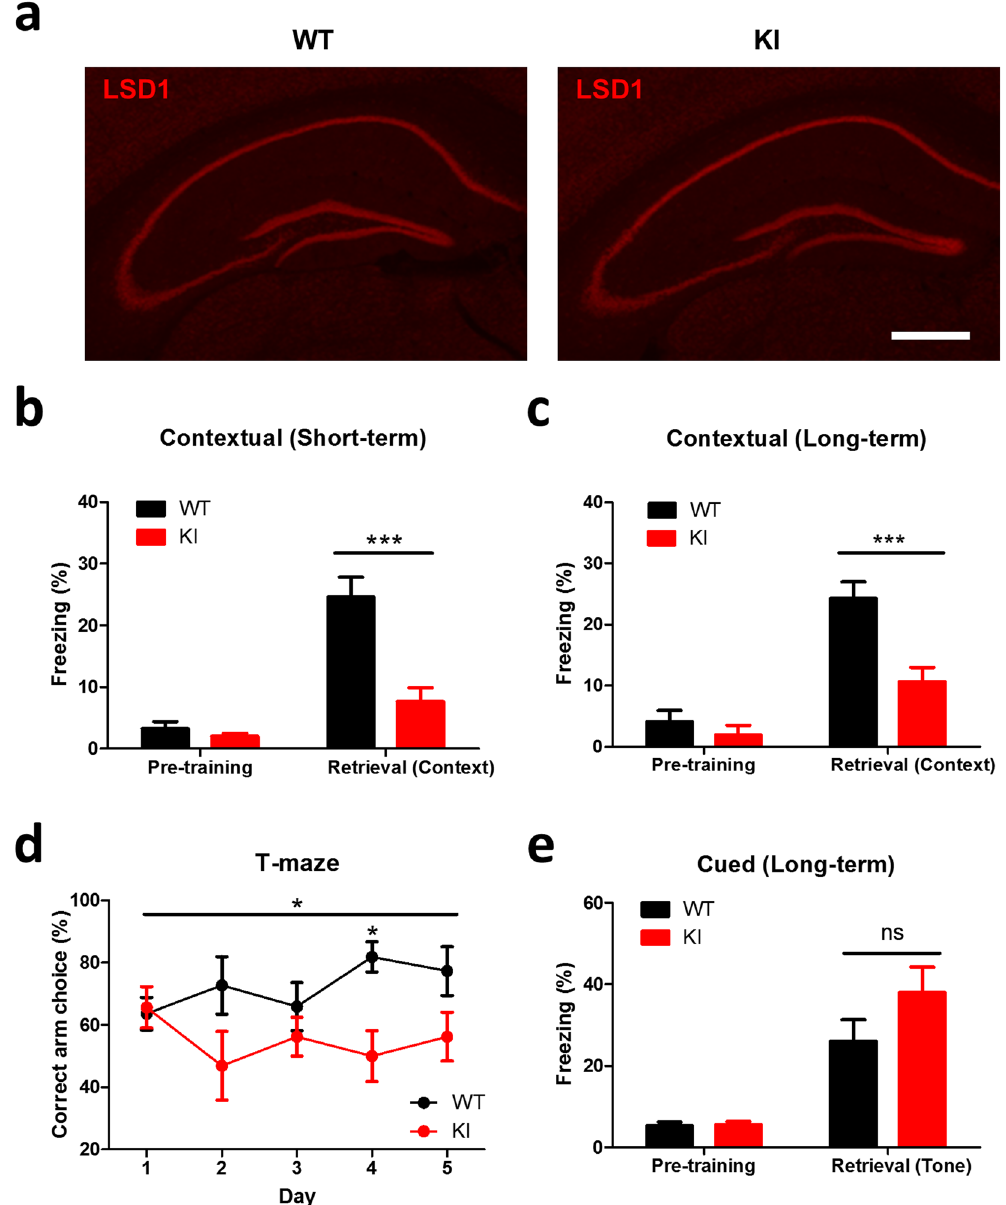
Figure 1. Lsd1 knock-in (KI) mice show impaired hippocampus-dependent fear memory. ( a ) Representative immunohistochemical images (from 5 different animals for each genotype) showed no difference in LSD1 expression pattern in the hippocampus of WT and Lsd1 KI mice. Scale bar: 500 μ m. ( b ) Freezing levels of WT (black) and Lsd1 KI (red) mice before (pretraining) and 1 h after (retrieval) contextual fear conditioning. Lsd1 KI mice showed significantly reduced freezing levels during retrieval test compared to WT (WT: n = 7, KI: n = 6; two-way ANOVA, genotype x condition, F 1,22 = 13.58, p < 0.01; effect of genotype, F 1,22 = 18.21, p < 0.001; effect of condition, F 1,22 = 40.07, p < 0.0001; Bonferroni posttests, *** p < 0.001). ( c ) Freezing levels of WT (black) and Lsd1 KI (red) mice before (pretraining) and 24 h after (retrieval) contextual fear conditioning. Lsd1 KI mice showed significantly reduced freezing levels during retrieval test compared to WT (WT: n = 9, KI: n = 9; two-way ANOVA, genotype x condition, F 1,32 = 7.06, p < 0.05, effect of genotype, F 1,32 = 13.36, p < 0.001, effect of condition, F 1,32 = 44.73, p < 0.0001; Bonferroni posttests *** p < 0.001). ( d ) Correct arm choice rate showed significant impairment in short-term memory in Lsd1 KI mice (WT: n = 11; KI: n = 8; two-way RM ANOVA, genotype x time, F 4,68 = 1.83, p = 0.133, effect of genotype, F 1,68 = 7.53, * p < 0.05, effect of time, F 4,68 = 0.37, p = 0.826; Bonferroni posttests, WT vs KI at day 4, * p < 0.05). ( e ) Freezing levels of WT (black) and Lsd1 KI (red) mice before (pretraining) and 24 h after (retrieval) cued fear conditioning. Lsd1 KI mice showed comparable freezing levels during retrieval test to WT (WT: n = 8, KI: n = 9; two-way ANOVA, genotype x condition, F 1,30 = 1.94, p = 0.174, effect of genotype, F 1,30 = 2.08, p = 0.160, effect of condition, F 1,30 = 40.15, p < 0.0001; Bonferroni posttests, ns: not significant). All graphs were plotted as mean ±